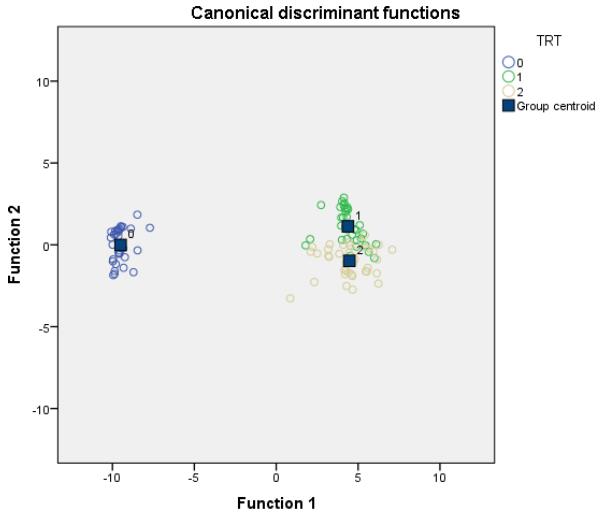
Figure 2. Canonical discriminant functions for the three seasons: 0, CDS; 1, HSD; and 2,